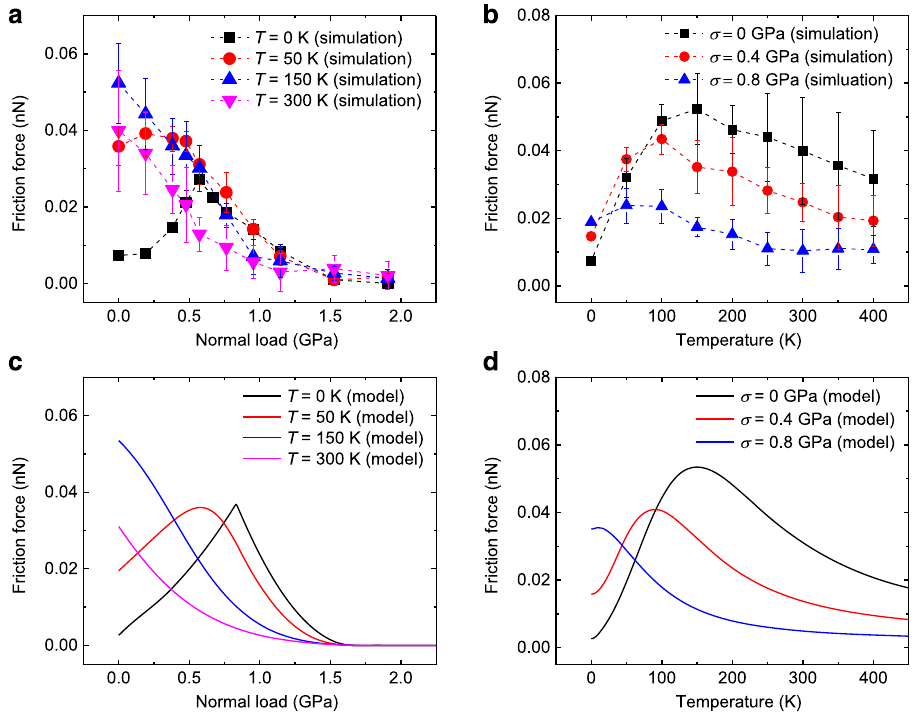
Fig. 2 Load and temperature dependence of friction. Molecular dynamics simulation results of a load dependence of friction at representative temperatures of T = 0, 50, 150, and 300 K and b temperature dependence of friction at representative normal loads of σ = 0, 0.4, and 0.8 GPa for the model system presented in Fig. 1. Here, the supercell contains a total grain boundary of length (cid:3) 28nm. c , d show results obtained using the phenomenological model for c the load dependence of friction at several temperatures, and d the temperature dependence of friction under several normal loads. The model parameters extracted from the dynamical simulations, are: 4 E 1 ¼ 0 : 01 eV, 4 E 2 ¼ 0 : 1 eV, α 1 ¼ 0 : 06eV = GPa, α 2 ¼ 0 : 03eV = GPa, ¼ 0 : 005 eV, Δ x ¼ 10 : 8Å, f ¼ 1 : 5 ´ 10 11 s (cid:2) 1 , N ¼ 18, and v ¼ 5m = s : The error bars in panels a and b represent the standard deviations β ¼ 0 : 3, c 0 0 0 obtained from averaging friction forces of 3 – 13 consecutive sliding periods. Representative lateral force traces at different normal loads and temperatures, and further details regarding the friction force calculations can be found in Supplementary Note 1. Additional details regarding the phenomenological model are given in Supplementary Note